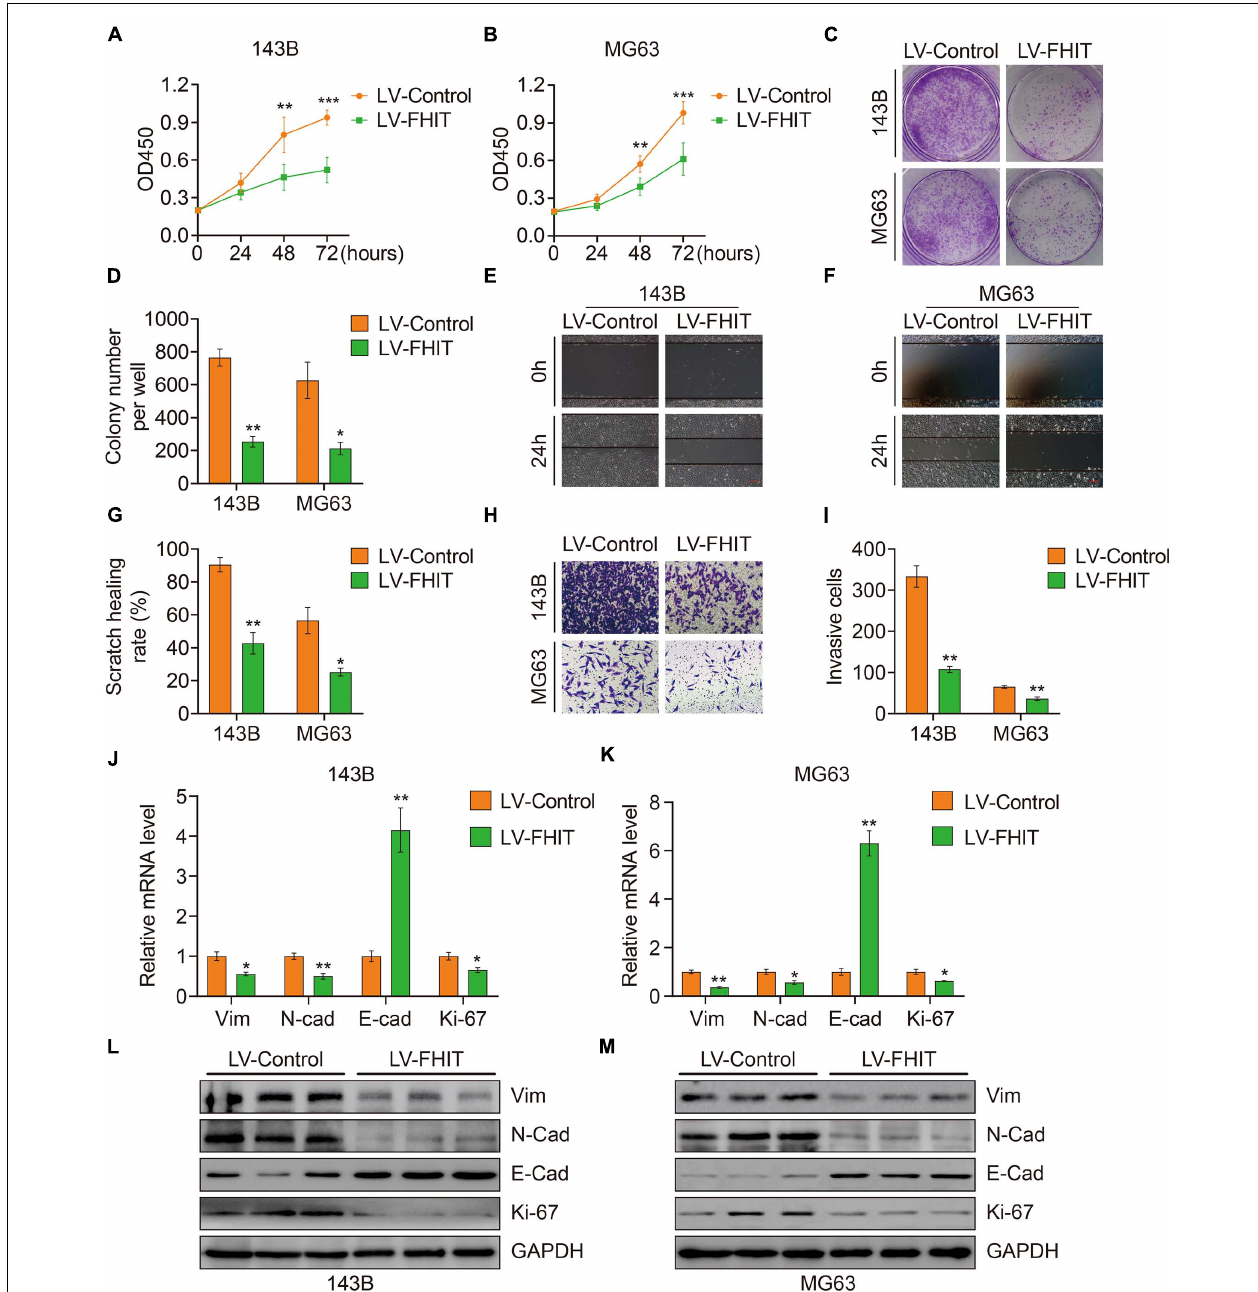
FIGURE 9 | The effect of FHIT on osteosarcoma cell proliferation, migration, and invasion. CCK-8 (A,B) and colony formation assays (C,D) were used to assess the osteosarcoma cell proliferation. (E–G) A wound healing assay was performed to estimate the effect of FHIT overexpression on cell migration. Scale bar, 0.2 mm. (H,I) A transwell invasion assay was conducted to assess the effect of FHIT overexpression on osteosarcoma cell invasion. (J,K) The mRNA expression levels of EMT-related genes were detected by qRT-PCR. (L,M) Protein expression levels of vimentin, N-cadherin, E-cadherin, and Ki67 after overexpression of FHIT were measured by western blot analysis. * P < 0.05, ** P < 0.01, *** P <